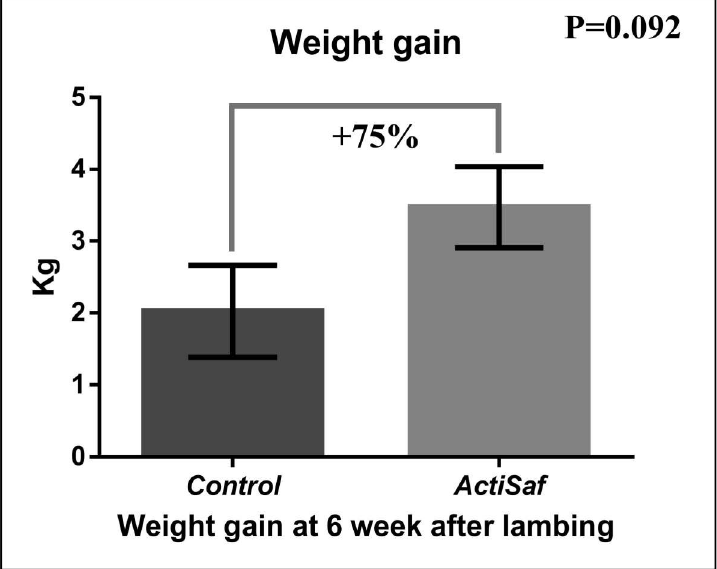
Figure 2. Graphical representation of body weight gain (recovery) between lambing and 6th week of lactation of ewes in Control (black, n = 51 ewes) and ActiSaf (grey, n = 53 ewes) groups (mean ± SE). Milk, fat corrected milk 6% (FCM 6% ), and energy corrected milk yield (ECM) were numerically increased by 7.6 (2.50 vs. 2.69 kg / day, SEM = 0.159, p = 0.395), 12 (2.07 vs. 2.32 kg / day, SEM = 0.126, p = 0.161), and 10% (1.93 vs. 2.13 kg / day, SEM = 0.116, p = 0.231), respectively, in the ActiSaf